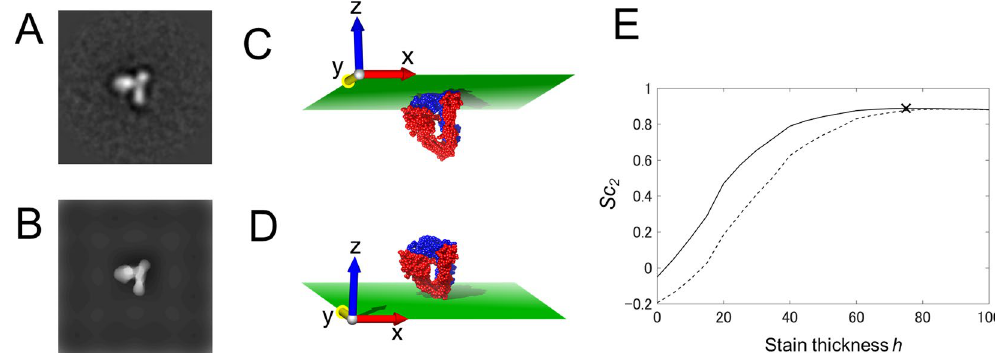
Figure 2. Negative stain models of X-ray crystal structure for different contact models and stain thicknesses. ( A ) EM image of integrin in Ca 2 + solution (Ca-003 in Supplementary Fig. S1). ( B ) Optimum negative stain model reproduced from X-ray crystal structure. ( C , D ) Illustration of two different contact models of X-ray crystal structure in the orientation used for building the negative stain model in ( B ). They contact the supporting film ( C ) at the top (top contact model) and ( D ) at the bottom (bottom contact model). ( E ) Plot of Sc 2 scores for EM image versus stain thickness h . The solid line represents the scores of the top contact models ( C ), and the dotted line represents those of the bottom contact models ( D ). The highest score is indicated by the